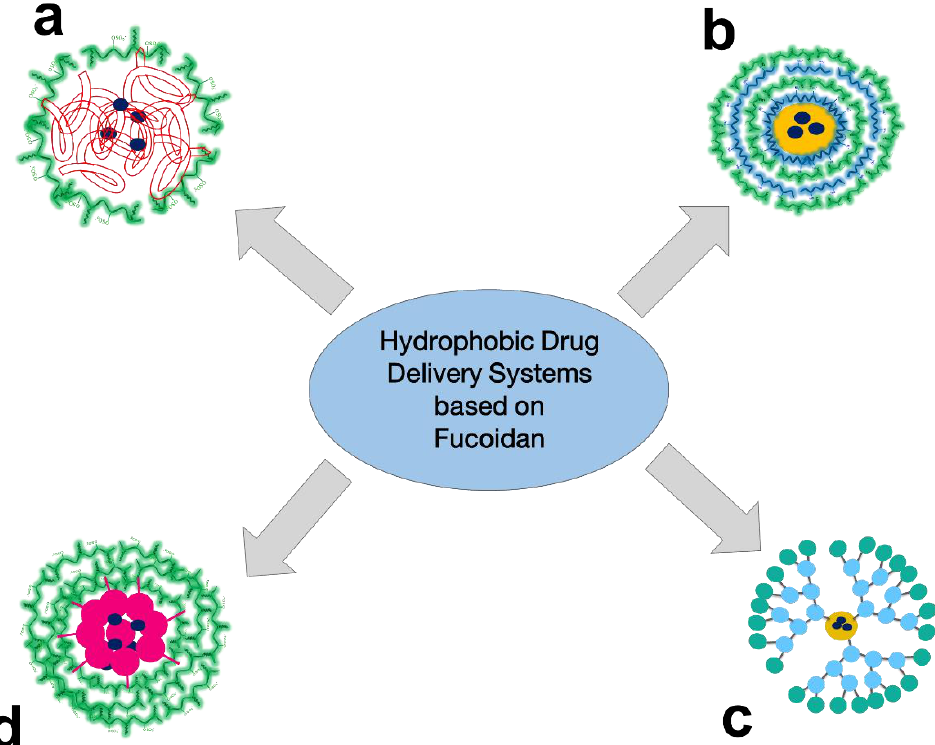
Figure 4. The main techniques for pharmaceutical R&D of FUC-based PECs for delivery of hydrophobic drugs: NP with hydrophobic core and hydrophilic shell ( a ), NP with hydrophobic core and layer-by-layer shell ( b ), dendrimer-based NP ( c ), and self-assembled NP based on hydrophobic-modified FUC ( d ).